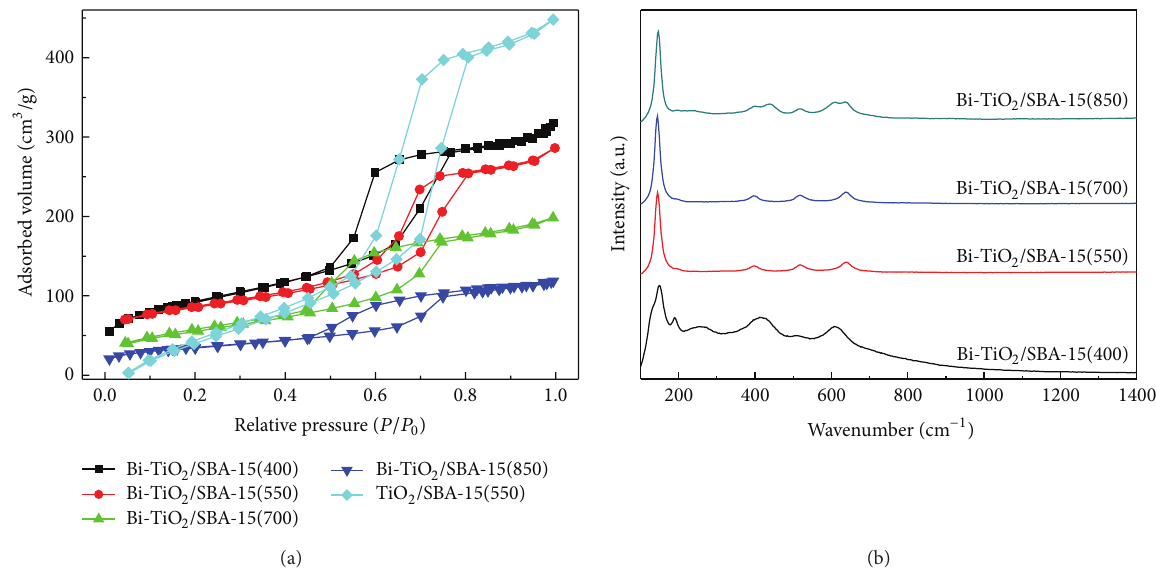
Figure 2: (a) N 2 adsorption-desorption isotherms of Bi-TiO 2 /SBA-15( x ). (b) Raman spectra of Bi-TiO 2 /SBA-15( x ).